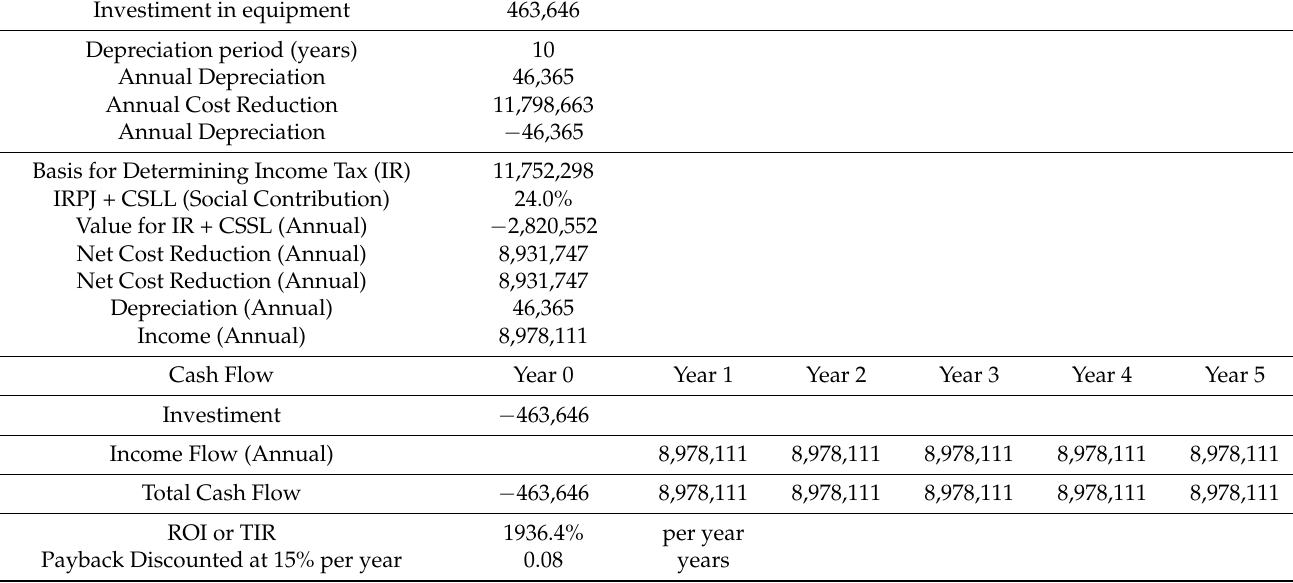
Table 6. Assessment of return on